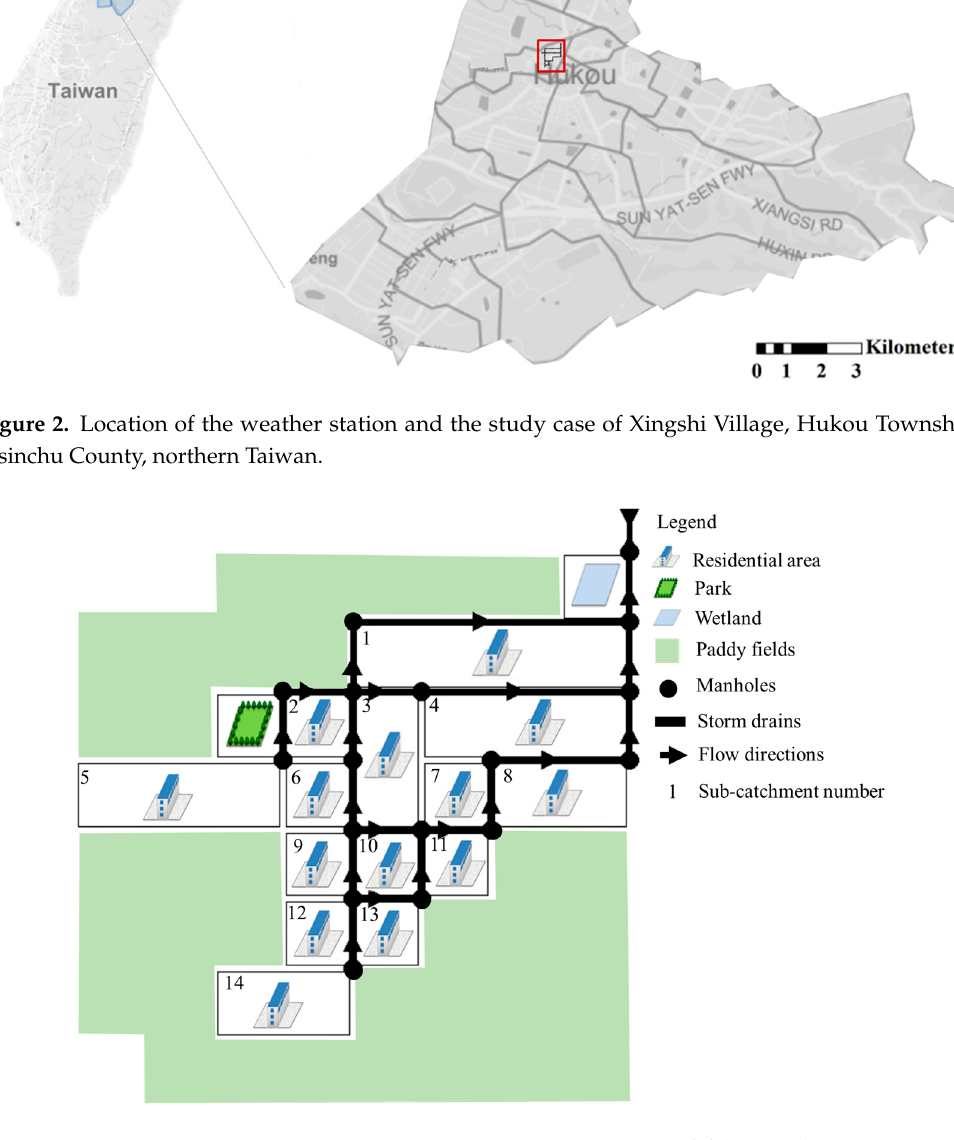
Figure 3. Design case in Storm Water Management Model (SWMM). Table 2. Characteristics for the design case.